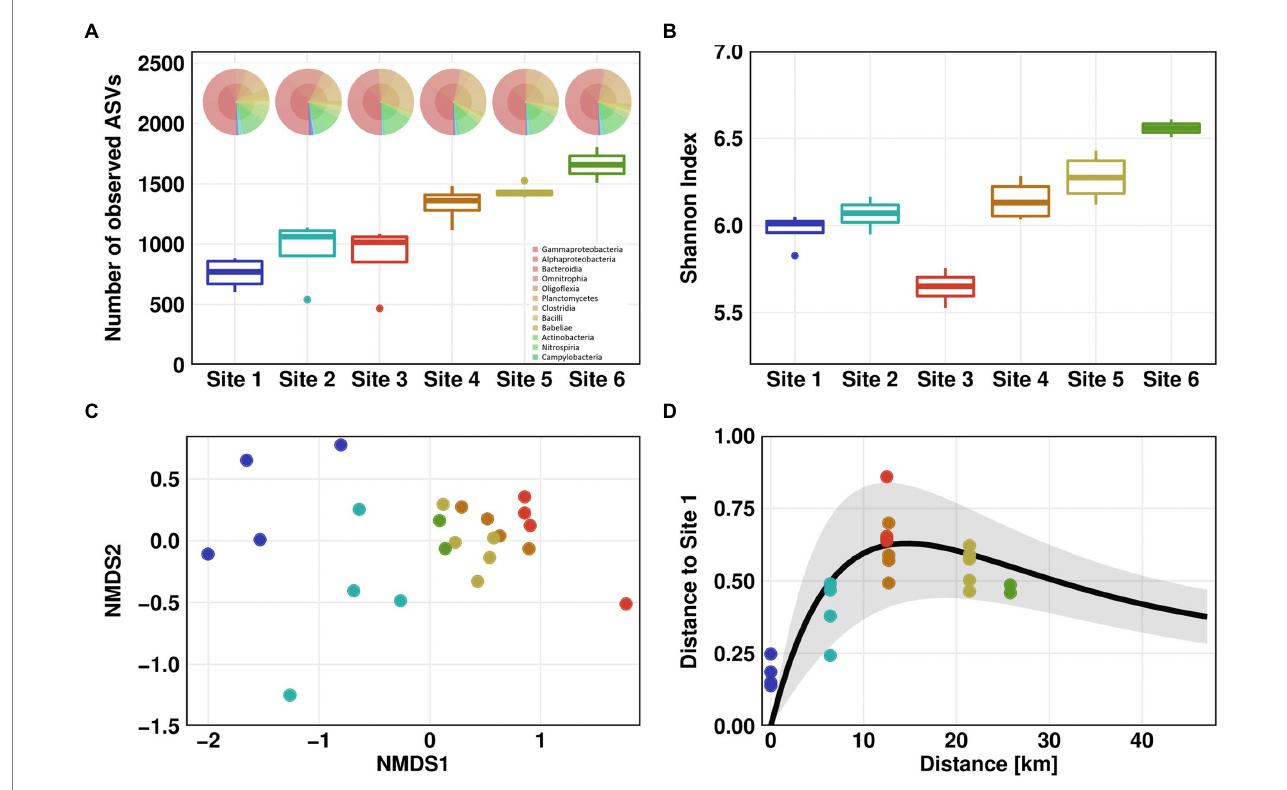
FIGURE 3 Microbial community structure. Microbial community alpha diversity based on 16S rRNA amplicon sequencing data using Observed (A) and Shannon measurement (B) . KRONA charts showing microbial community structure on genus level are displayed on top of (A) for February 26th, 2021. Microbial community beta diversity based on 16S rRNA amplicon sequencing data, ordination by non-metric multidimensional scaling (NMDS) of Bray–Curtis dissimilarities (C) . Impulse model showing the displacement from the pristine state at Site 1 (D) . For Sites 1–4, one outlier was removed in each dataset before